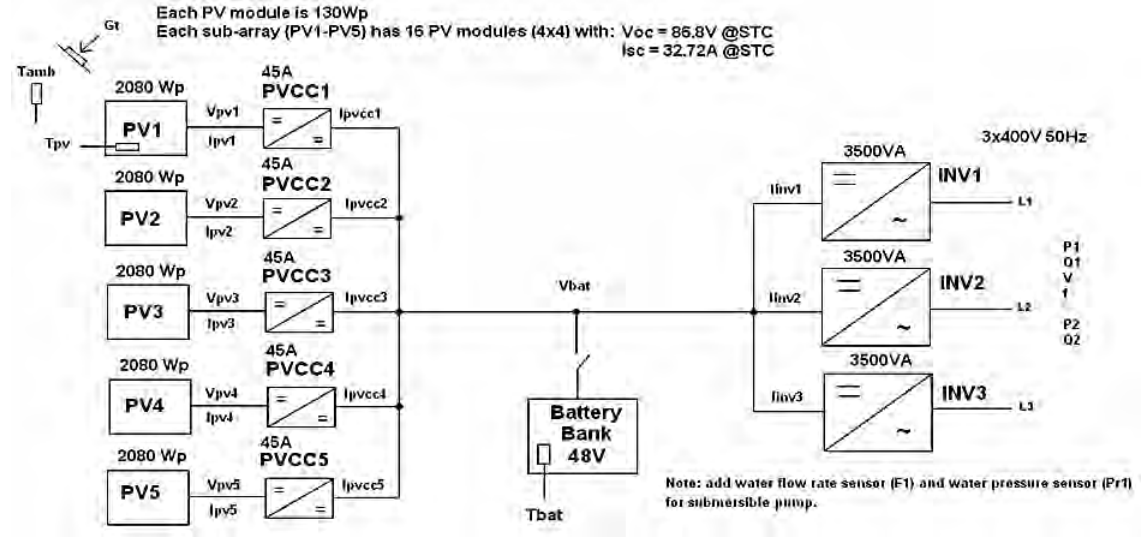
Figure 2. Block Diagram of the Measuring System